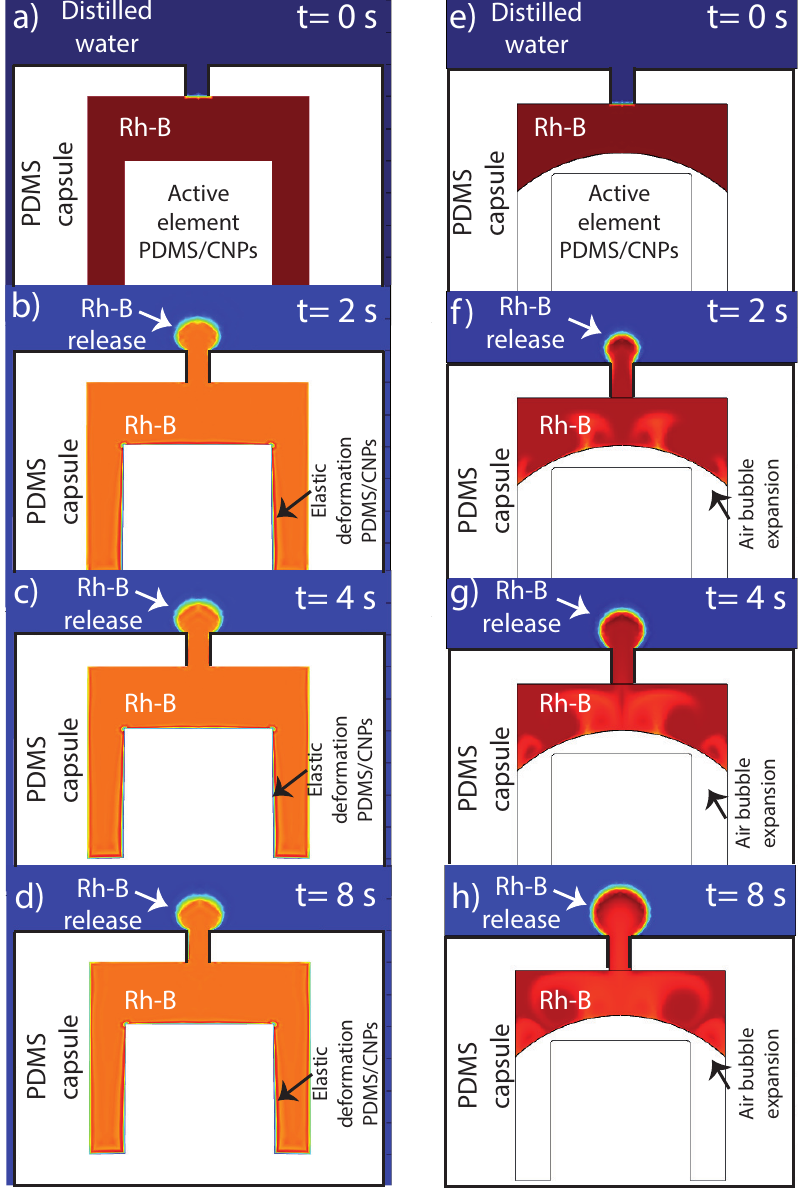
Figure 10. Numerical results explaining the internal phenomena that possibly occurs within the cap- sule during the drug release: ( a – d ) images corresponding to elastic deformation of the nanocomposite at different times; and ( e – h ) images simulating the presence of an air bubble that aided to the expul- sion of Rh-B under NIR irradiation of the nanocomposite. In order to visualize the evolution of the Rh-B release by numerical simulations, Videos S3 and S4 are available in Supplementary